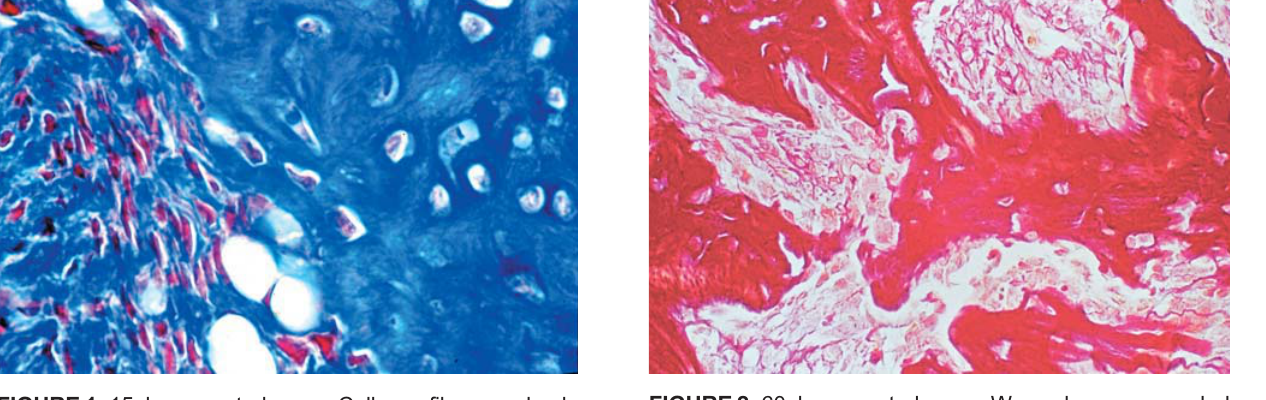
FIGURE 1- 15 days - control group. Collagen fibers randomly arranged characterizing an embryonic bone. (M.T., original magnification x400)